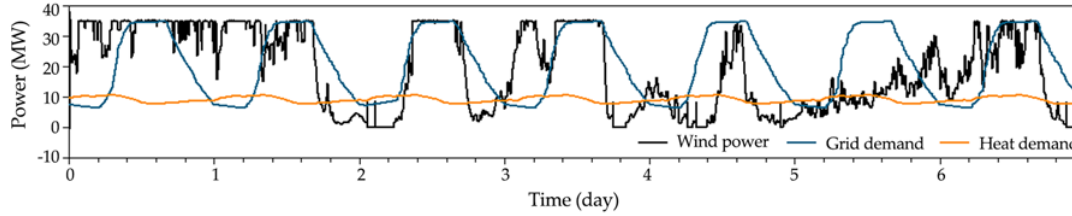
Figure 8. Daily profiles of the total wind power and the loads for a typical week in a heating season.